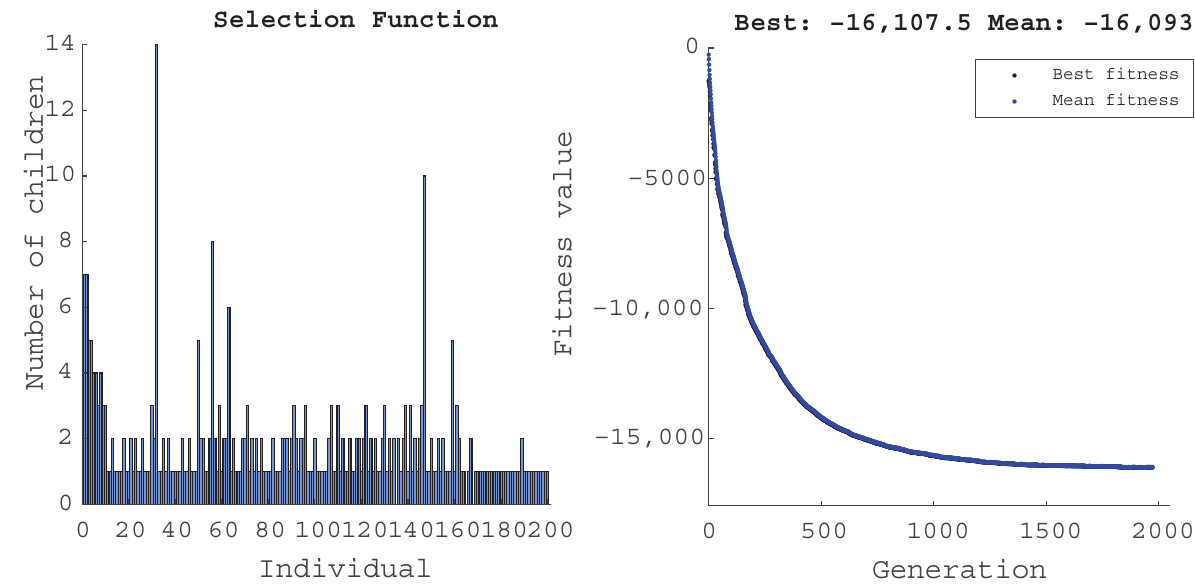
Figure 10. ANN results for a day during various seasons.